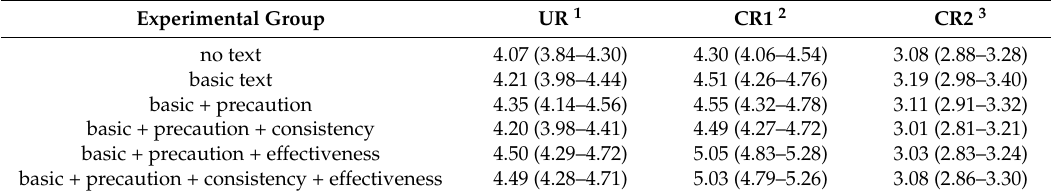
Table 4. Means (99% confidence intervals) of risk perception in the experimental